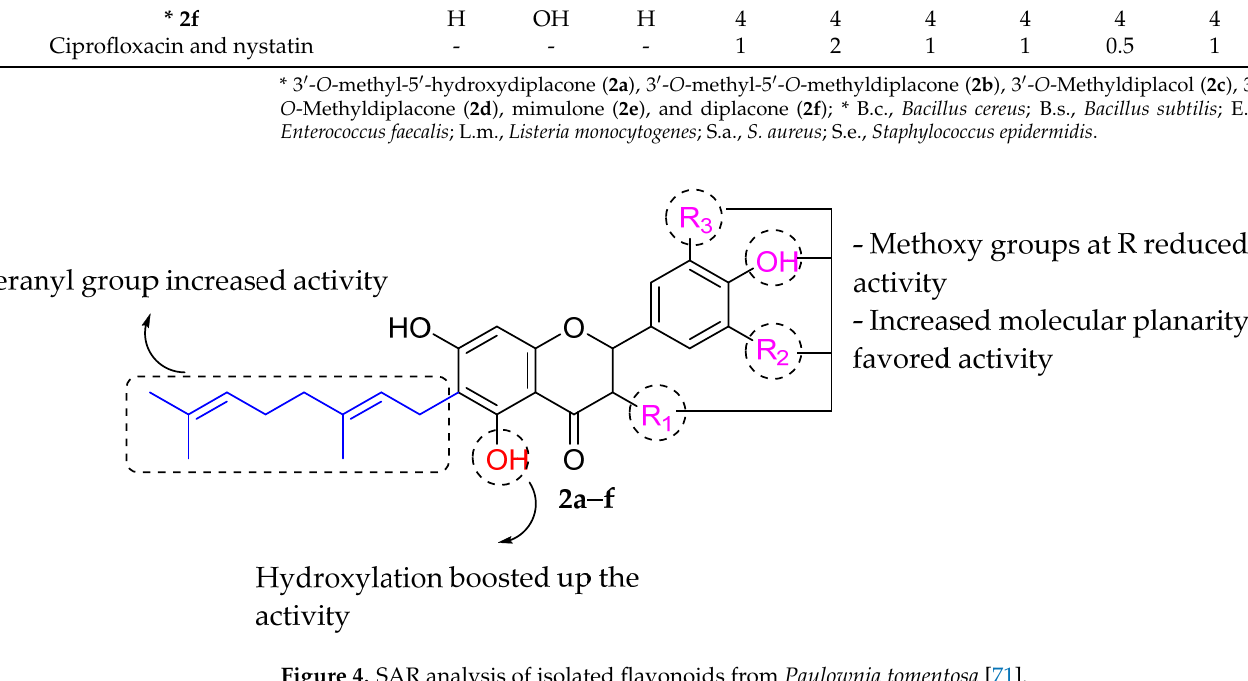
Table 3. Flavonoids compounds displayed good E. coli DNA gyrase inhibition.